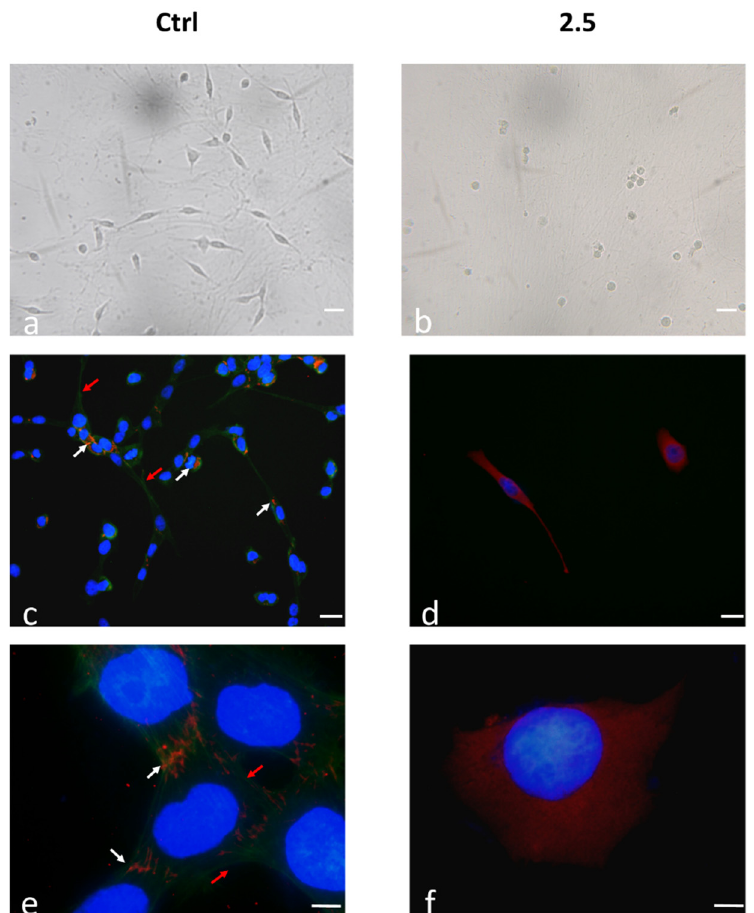
Figure 6. Cell morphology of 1321N growth on the extracellular matrix (ECM) coating untreated ( a ) and treated ( b ) with 2.5% v/v of Rapha Myr ® for 24 h. Images were acquired by optical inverted